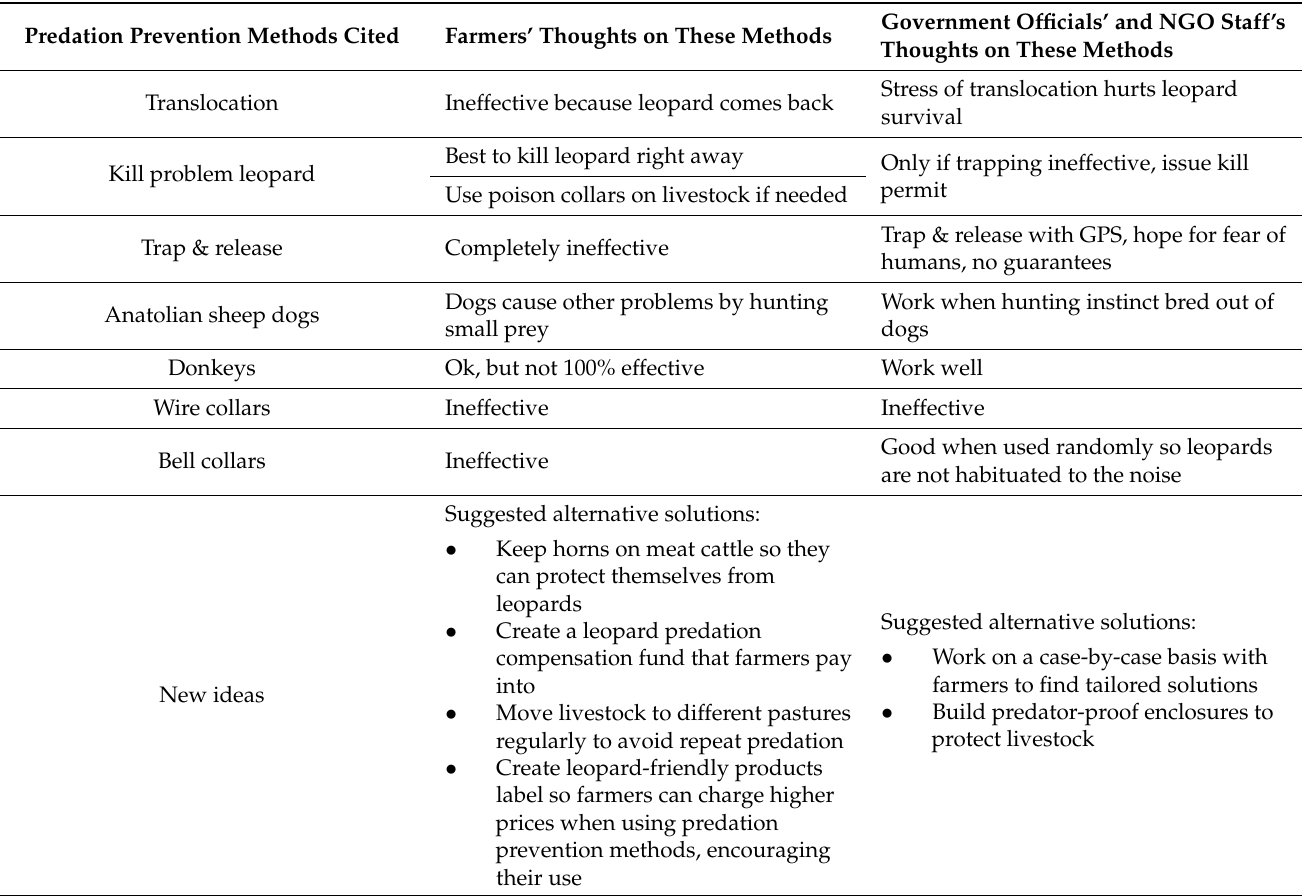
Table 3. Responses to human-leopard conflict cited by respondents and their perceived